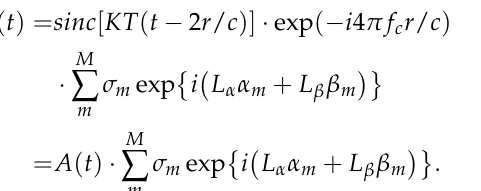
After down-conversion and LFM signal pulse compression, the echo is